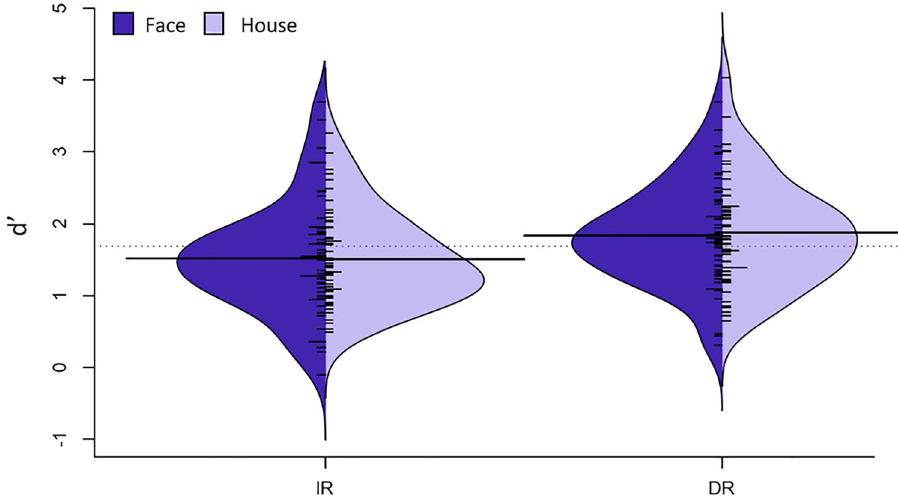
Fig. 2 Behavioural results (d ’ ) displayed by Split Violin plots. Split Violin plots of d ’ reveal no signi fi cant difference as a function of stimulus category (face vs. house) for IR or DR (all p ’ s > 0.962). Horizontal lines represent the mean. N = 54 healthy subjects.